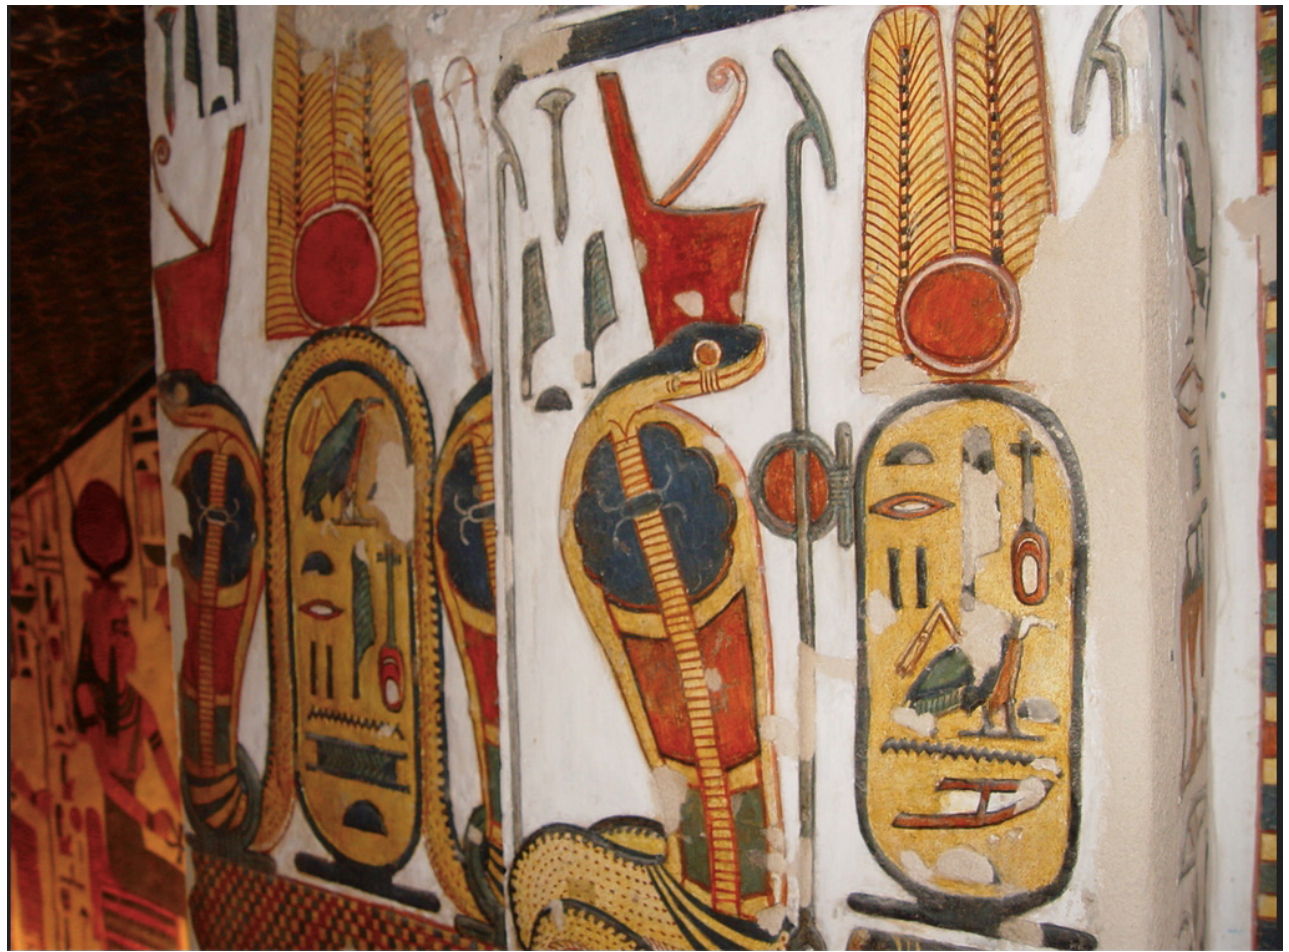
Figure 4. A painted vignette from the tomb (no. 66) of Nofertari in the Valley of the Queens identifying the cobra as the goddess Wadjet. Notice that the hieroglyphs spelling her name are painted green. Courtesy of Venerabilis Opus.